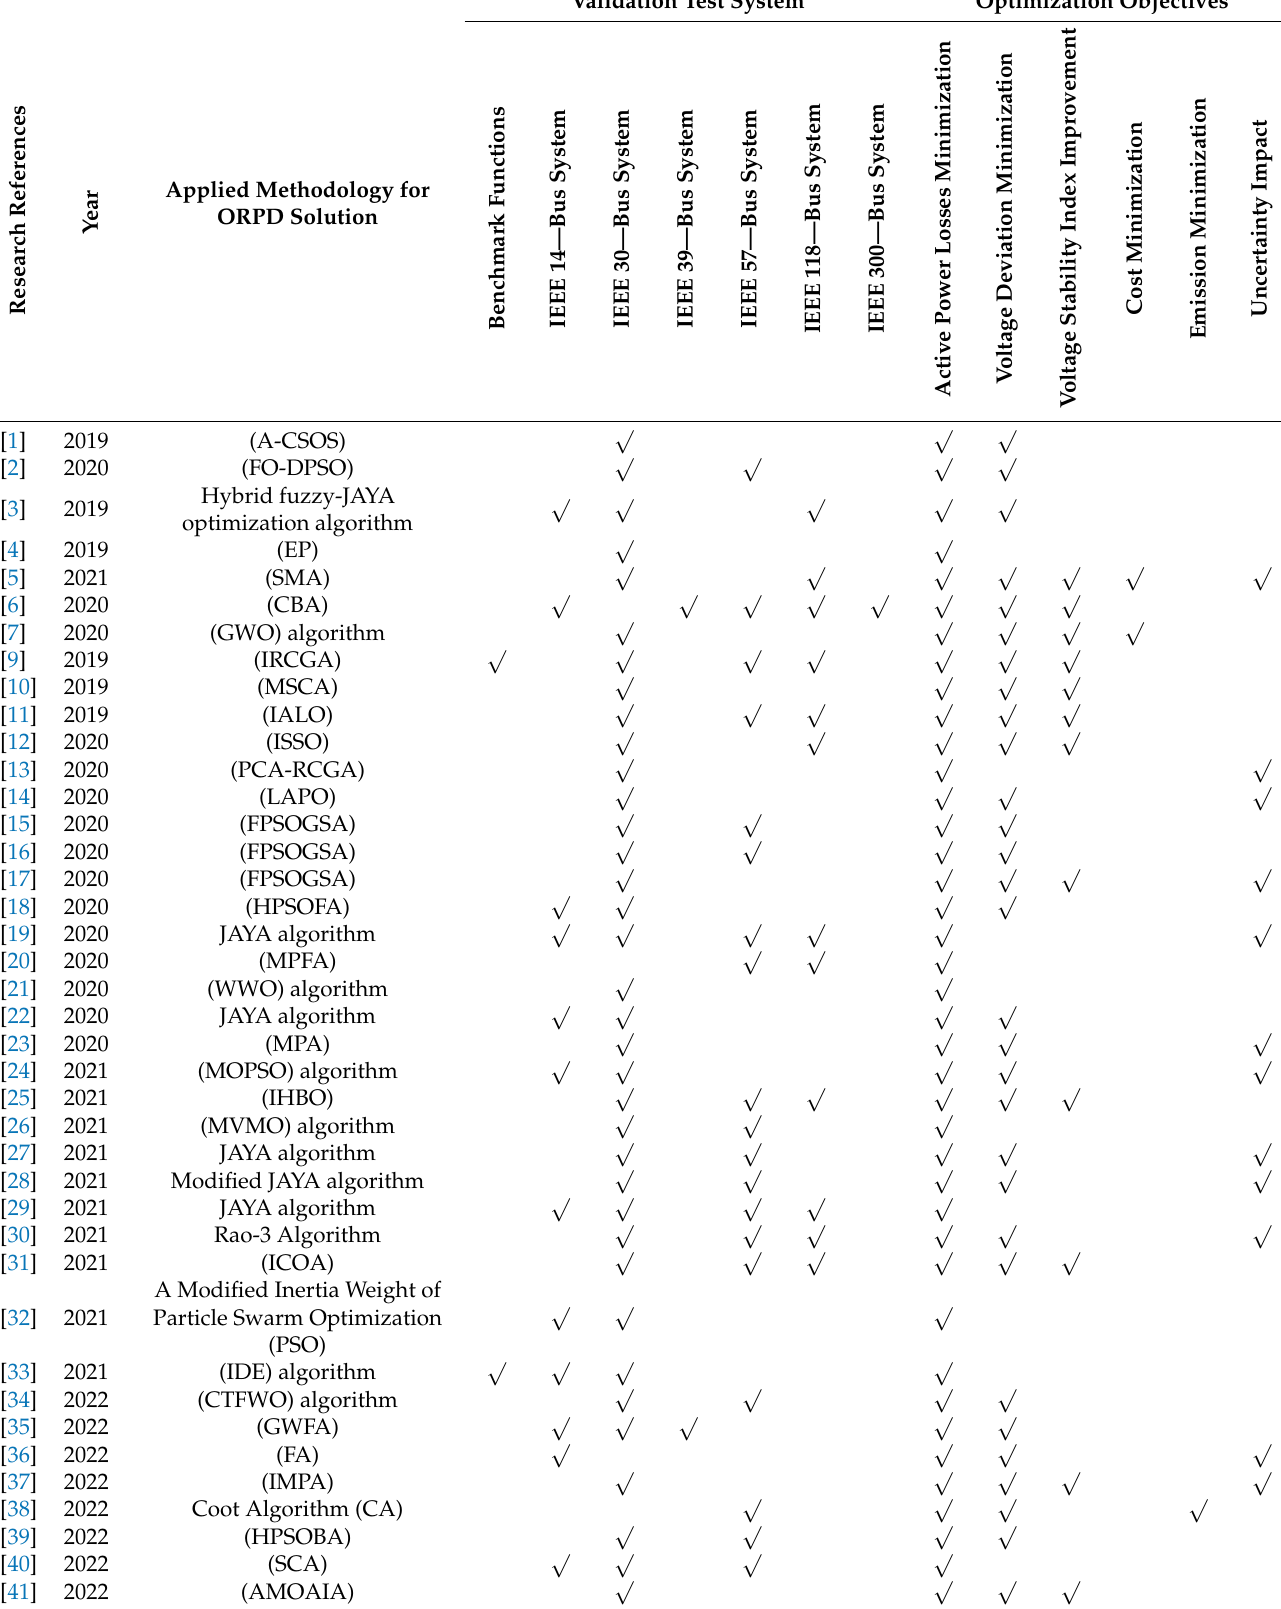
Table 1. Optimization Methods for ORPD Problem